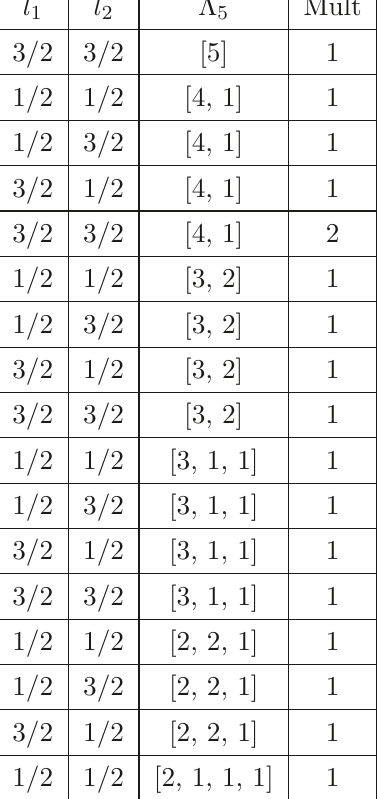
Table 10 . Results for n = 5 fields and k = 3